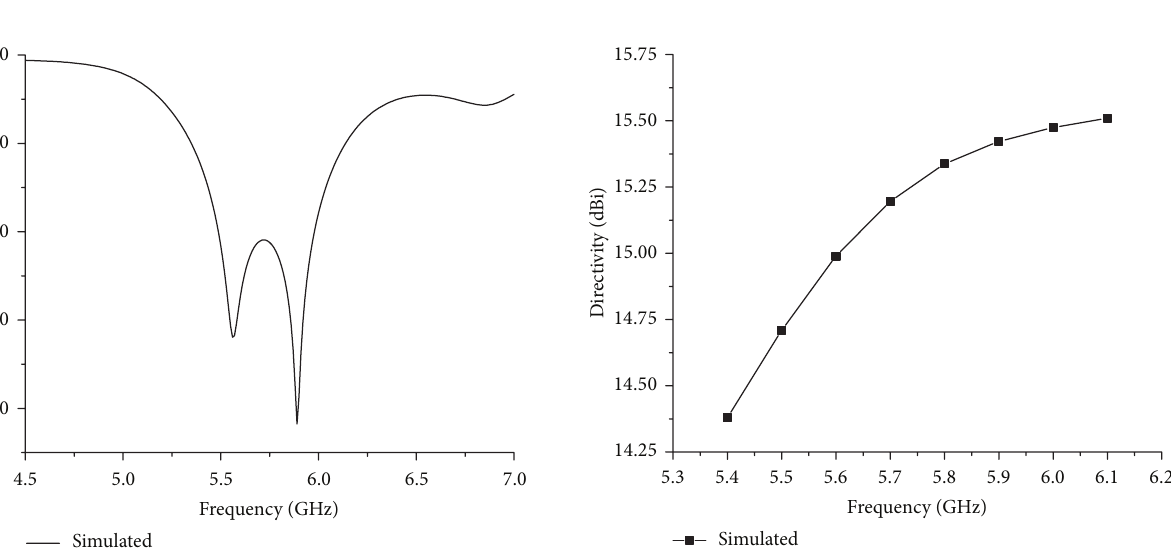
Figure 5: The simulated reflection coefficient of the square antenna array.